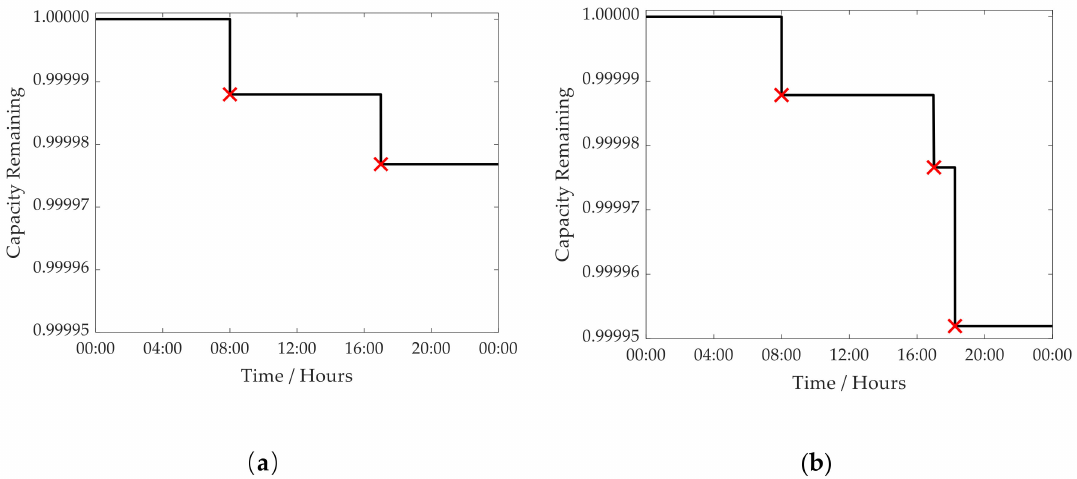
Figure 5. A comparison between the two step-plots showing the variance in capacity fade against time for: baseline cycle ( a ), V2G-optimised cycle ( b ), when utilising the holistic ageing model.